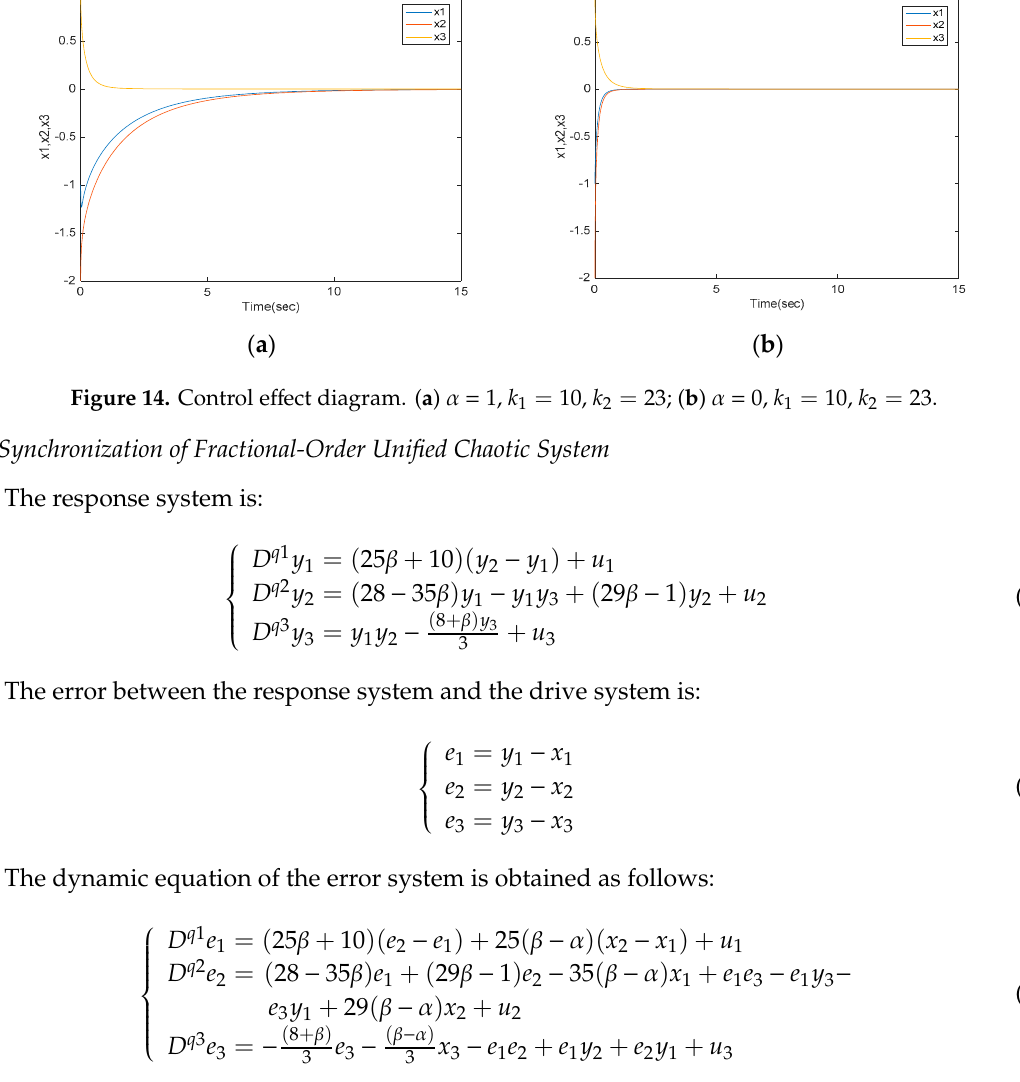
= 10, k = 23; ( b ) α = 0, k 2 1